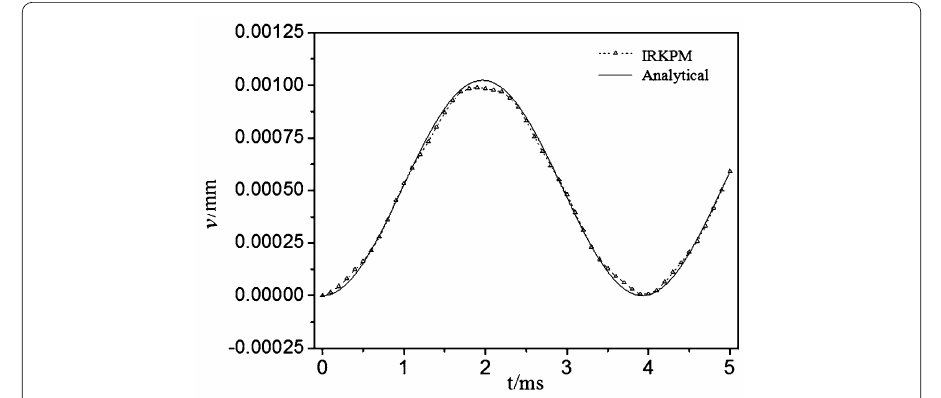
Figure 5 The time-dependent deflection of the midpoint of the free end